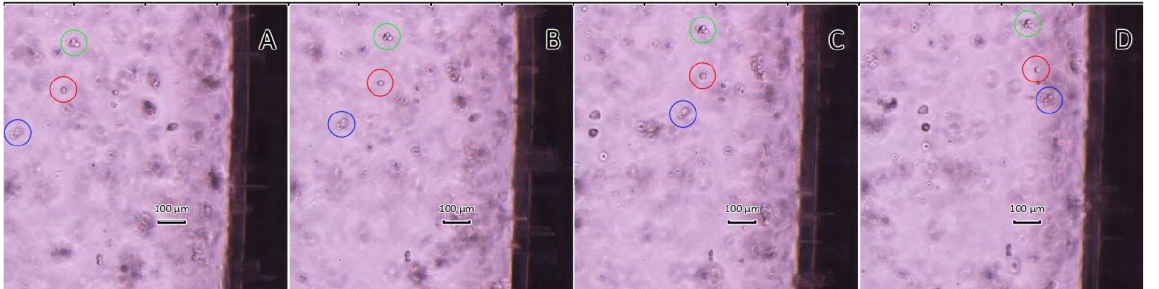
Figure 7. Snapshots from the video at different time intervals ( A – D ), which show the movement of the 4T1 breast cancer cell with CaCO 3 /MNP 3 /(BSA-Cy7/TA) 2 carriers (for example, cells are highlighted in green, red, blue circles) in the field of action of the permanent magnet (the magnet is located on the right).